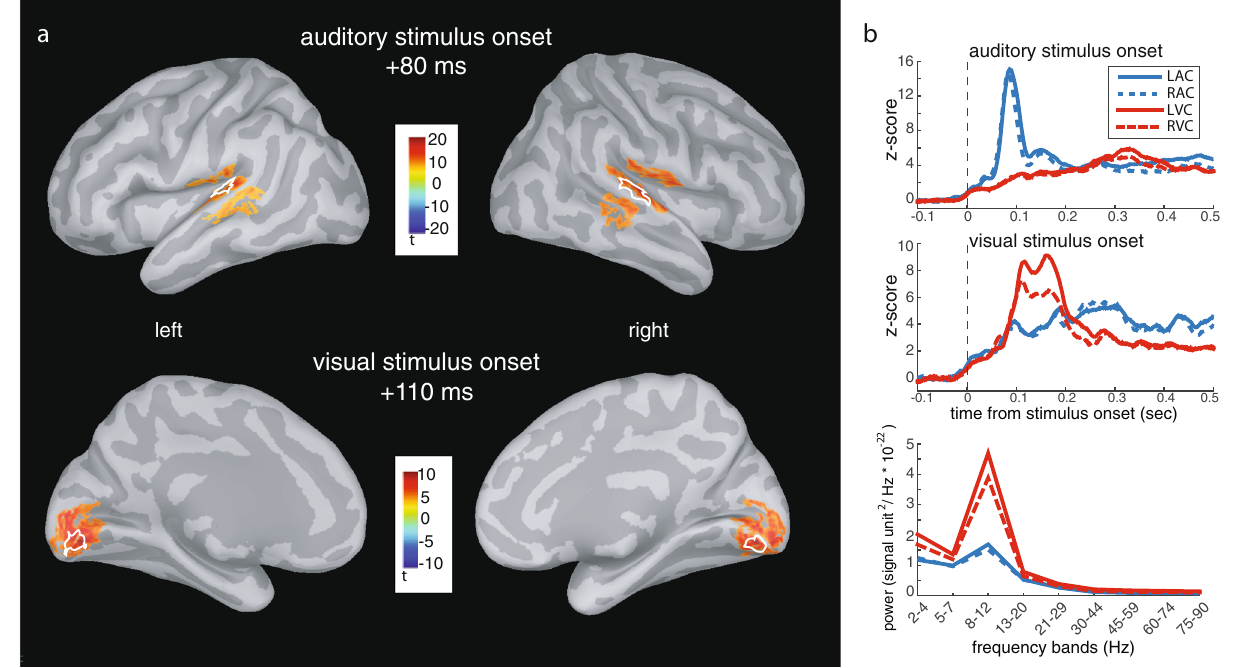
Fig. 3 Regions of interest: anatomy and basic neurophysiological responses. a MEG cortical source modeling of event-related brain responses. Group average ( n = 18) event-related brain responses to auditory stimuli initiated around 50 ms and were maximal at 80 ms after auditory stimulus onset and localized to left and right superior temporal gyri (LAC/RAC). Responses to visual stimuli peaked on average 110 ms post-stimulus and localized to left and right striate and extrastriate visual cortices (LVC/RVC). White outlines represent the regions of interest in one representative participant. b Region of interest time series and power spectrum densities. The group average source time courses depict activation across time extracted from the participants ’ ROIs for auditory and visual stimulus onsets (top and middle panels). Power spectrum density estimated over the pre-stimulus time period of all trials, across the indicated frequency ranges and for all ROIs (bottom each trial, PAC levels from task data and surrogate data were compared using their z-scores (Supplementary Table 1). Positive Z-scores indicate higher PAC scores for task trials. Across participants, Z-scores were strictly positive in 69 – 75% of the trials in all ROIs, indicative of a strong trend away from the surrogate data (Fig. 4b). Evaluation of the average Z-scores (LAC: Z = 1.64, RAC: Z = 1.54, LVC: Z = 1.82, RVC: Z = 1.72) against the critical